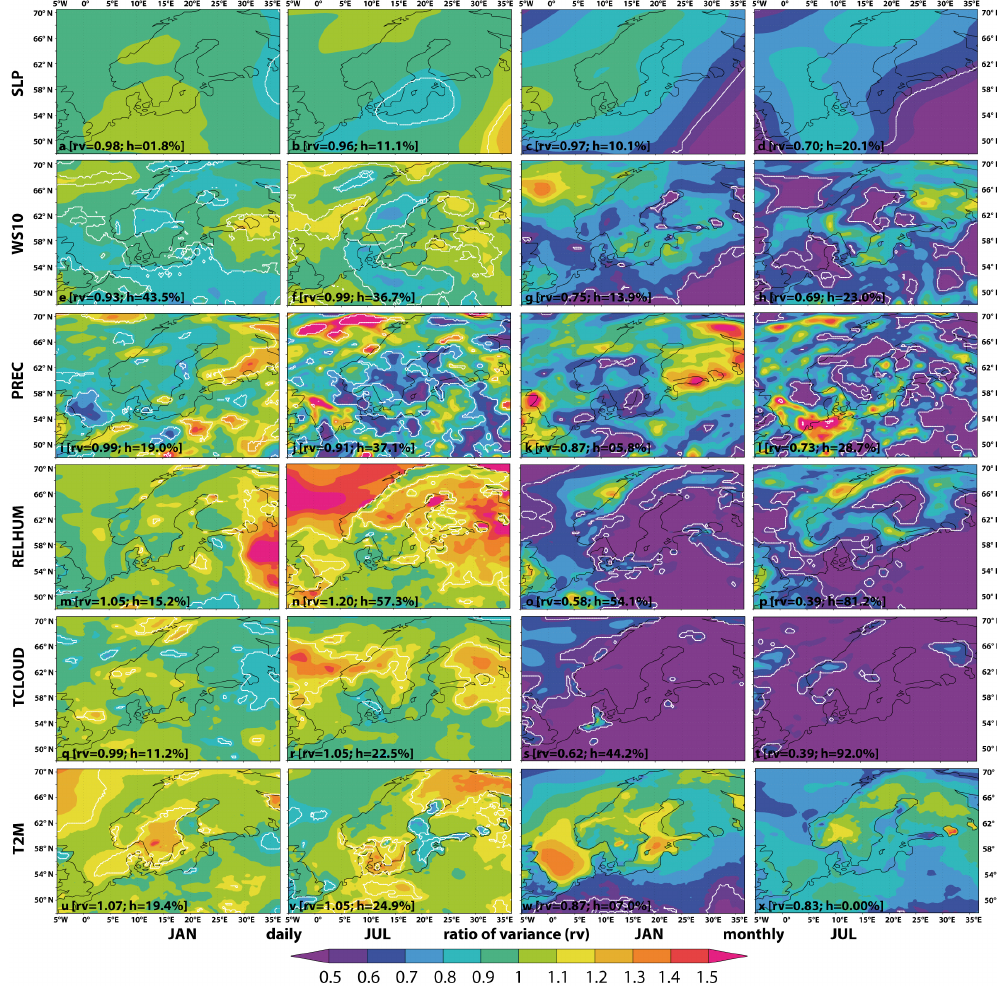
Fig. 7. Ratio of variance on daily (left column) and monthly (right column) scale between HiResAFF and the reference fields of RCAO (RCAX for T2M) for January and July 1958–2007. White shaded lines indicate areas where the reconstruction shows significant deviations in variance with p <